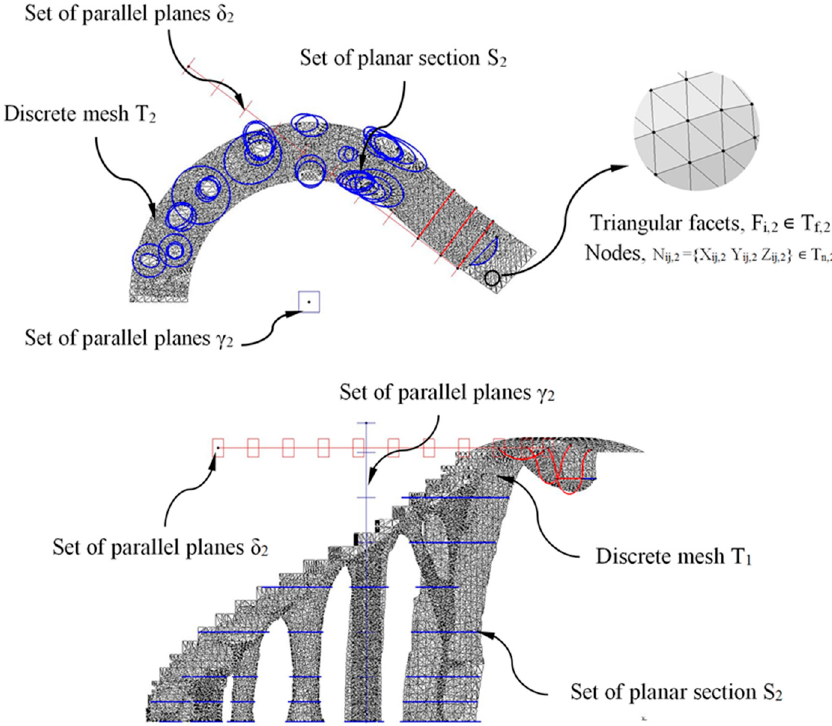
Figure 19. Definition of the sections S 2 generated by the Boolean operation of intersection between the discrete mesh T 2 and the set of planes δ 2 and γ 2 .